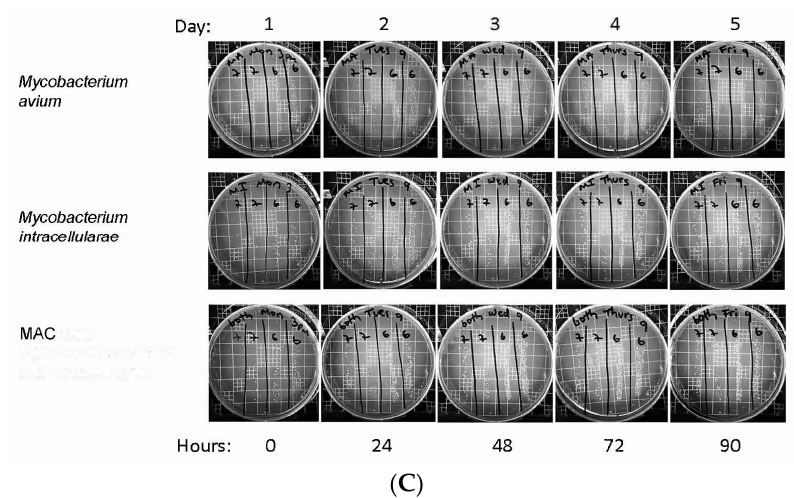
Figure 3. Bacterial growth kinetics of M. avium , M. intracellulare , and MAC ( M. avium combined with M. intracellulare ) over 90 h at ( A ) 10 −6 dilutions ( n = 7); and ( B ) 10 −7 dilutions ( n = 7). ( C ) Agarose plates of M. avium , M. intracellulare , and M. avium combined with M. intracellulare at 10 −6 and 10 −7 dilutions.